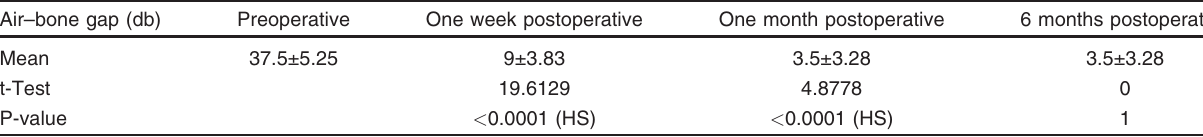
Table 1 Comparison between preoperative and postoperative air – bone gap (db) Air – bone gap